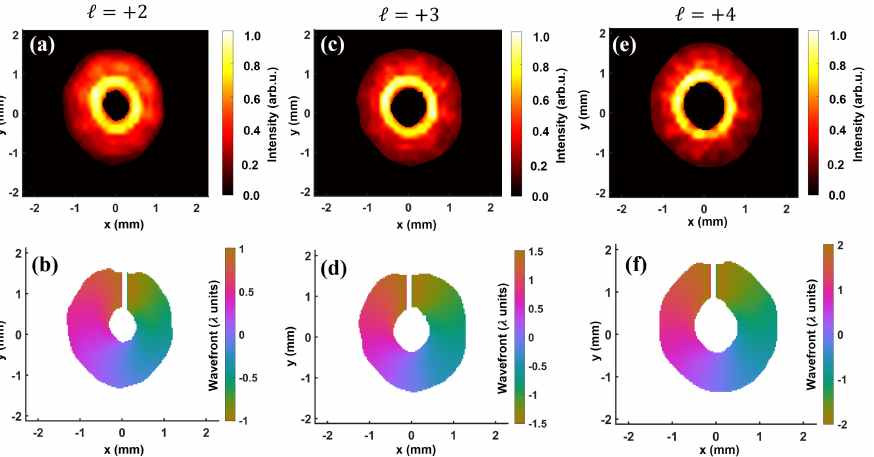
Figure 3. Characterization of vortex beams of higher topological charge. Intensity ( top ) and wavefront ( bottom ) for (cid:96) = 2 ( a ), 3 ( c ), and 4 ( e ). In all the cases, the intensity distribution presents an annular profile, whereas the wavefronts show a helical structure. The wavefront twists by ∼ 2.005 λ , ∼ 3.003 λ , and ∼ 4.0 λ for (cid:96) = 2 ( b ), 3 ( d ), and 4 ( f ), respectively. The clockwise wavefront rotation indicates the positive sign of the topological